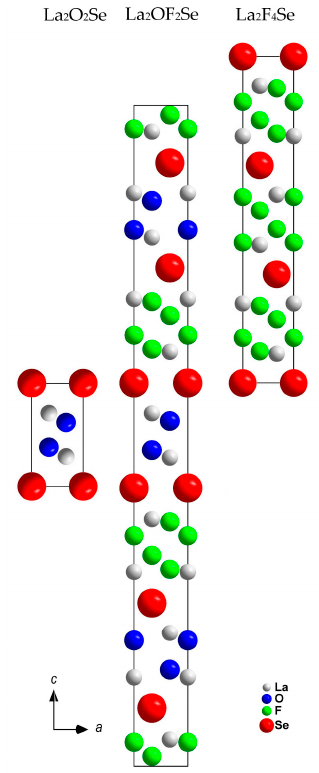
Figure 1. Comparison of the crystal structures of A-type La 2 OF 2 Se (mid) with La 2 O 2 Se (left) and La 2 F 4 Se